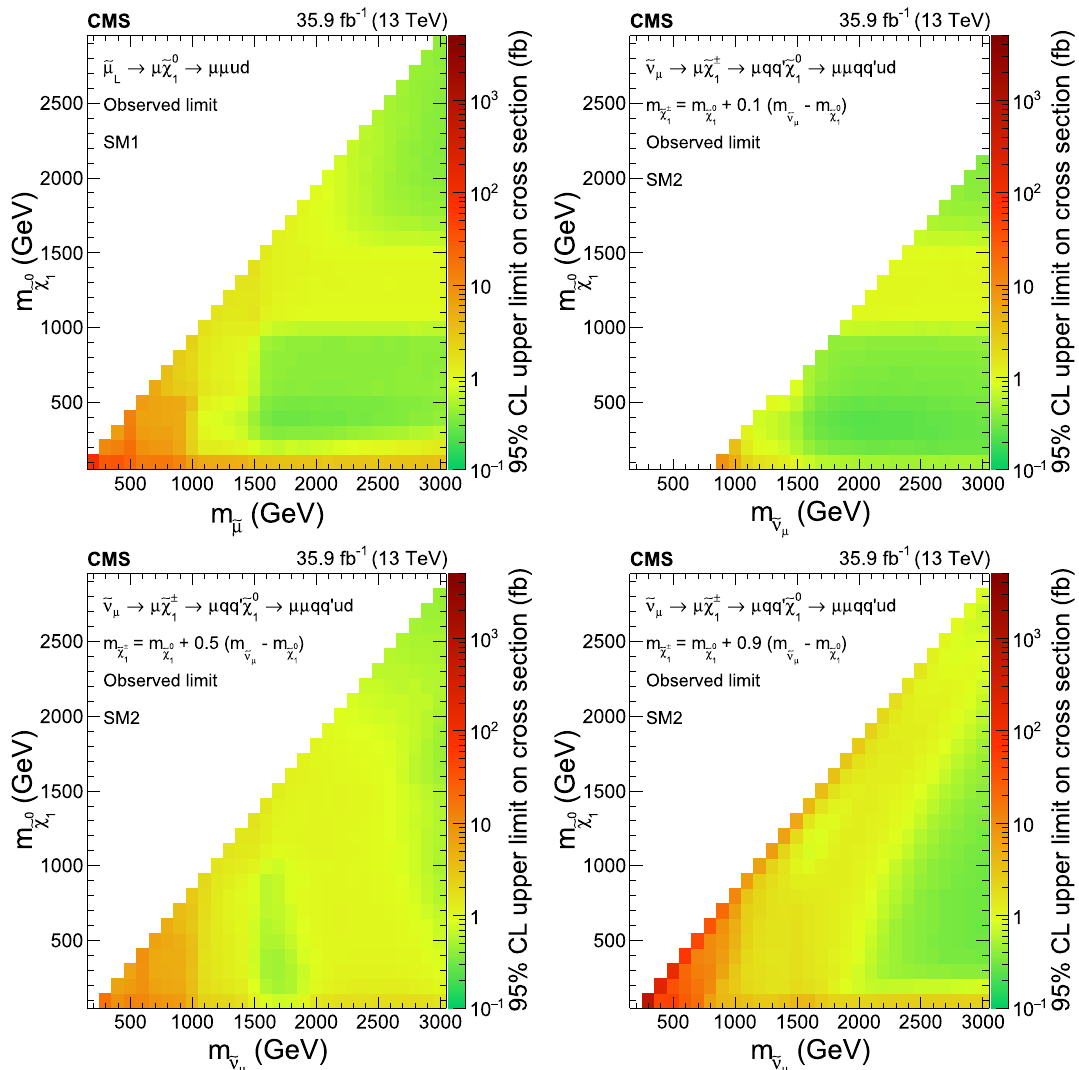
Fig. 4 Observed upper limits on cross sections at 95% CL. The upper (lower left) and x = 0 . 9 (lower right). The limit for a specific mass left plot shows the limit in the m (cid:2) χ 0 and m (cid:2) μ mass plane for SM1, while combination is depicted according to the color scale on the right-hand 1 side of the the other three plots show the SM2 limits as a function of m (cid:2) χ 0 and m (cid:2) ν μ 1 for the three different scenarios with x = 0 . 1 (upper right), x = 0 . 5